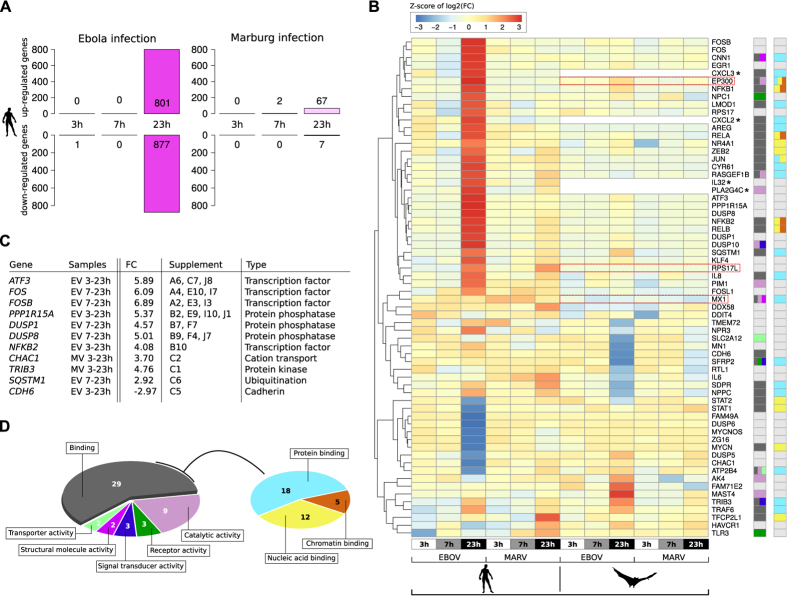
Significantly regulated genes in cells infected with EBOV or MARV.(A) Number of strongly regulated human genes after infection with EBOV or MARV. There were only a few genes that were significantly regulated (padj <0.1) at 3 and 7 h p.i. in both EBOV- and MARV-infected cells compared with their expression in Mock-treated cells. At 23 h p.i., the number of regulated genes was higher (1,678) in EBOV-infected cells than in cells infected with MARV. Adding these ~1,600 strongly regulated genes to the findings from analyses comparing the different time points or viruses resulted in approximately 2,500 genes being identified as significantly differentially transcribed. (B) Heat map of row-scaled log2-fold changes in expression in infected HuH7 and R06E-J-samples against the corresponding Mock samples (e.g., column three shows the fold change between HuH7 Mock-treated cells and HuH7 EBOV-treated cells at 23 h p.i.). The input matrix is scaled within the rows to visualize changes in expression at the gene level. Fold changes are based on unique genome read counts of H. sapiens and R. aegyptiacus. Genes without a clear homologous sequence in the R. aegyptiacus genome or transcriptome assembly are marked with a star. We identified homologous locations (LOC107508087, LOC107515336, LOC107498547) for three genes that were not directly annotated in the R. aegyptiacus genome (EP300, RPS17L, MX1). These locations were identified using our de novo transcriptome assembly (red boxes). We indicated the molecular function of each gene based on the color scheme presented in (D). (C) Highly regulated genes in EBOV- and MARV-infected HuH7 and R06E-J cells. FC – log2-fold change based on DESeq normalized read counts. See Supplement (Tables S5 and S6) and corresponding entries for detailed information. (D) The PANTHER database (v11.0)96 was used to assign molecular functions to each of the 64 genes in (B) We further subdivided the dominant group of genes that we identified to have a general binding function. During filovirus infections, the most prominent regulatory effects were observed for genes encoding transcription factors, those regulating the NFκB and MAPK pathways, their DUSP inhibitors and growth factors (Figure ES2A and Tables S5 and S6, full tables in the electronic supplement). In addition, changes were also observed for genes that regulate protein translation (RPS17, PPP1R15A), ubiquitination (TRAF6, SQSTM1), autophagocytosis (SQSTM1) and cation transport (CHAC1, ATP2B4). We also observed the strong up-regulation of genes that are involved in energy transfer (e.g., RASGEF1B). Details can be found in Tables S5–S8.